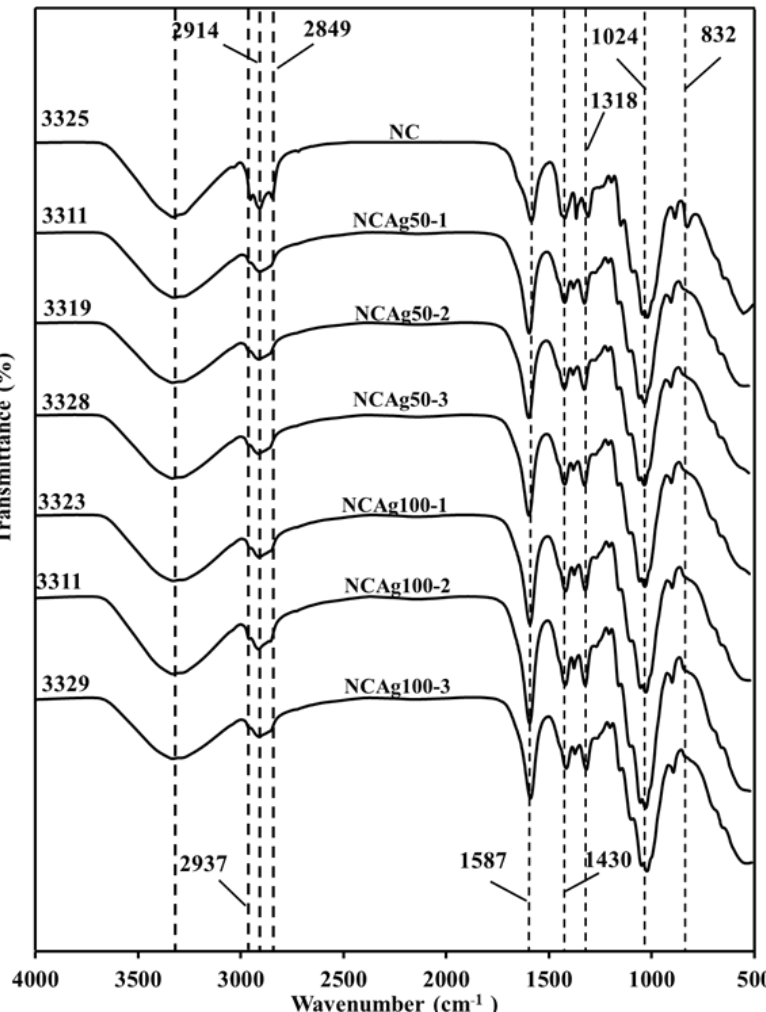
Figure 4. FTIR spectra of NC, NCAg50, and NCAg100 films.